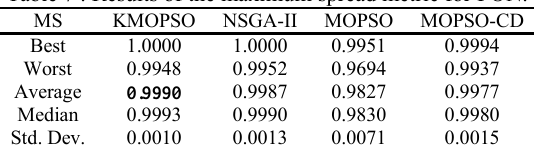
Table 7 . Results of the maximum spread metric for FON.